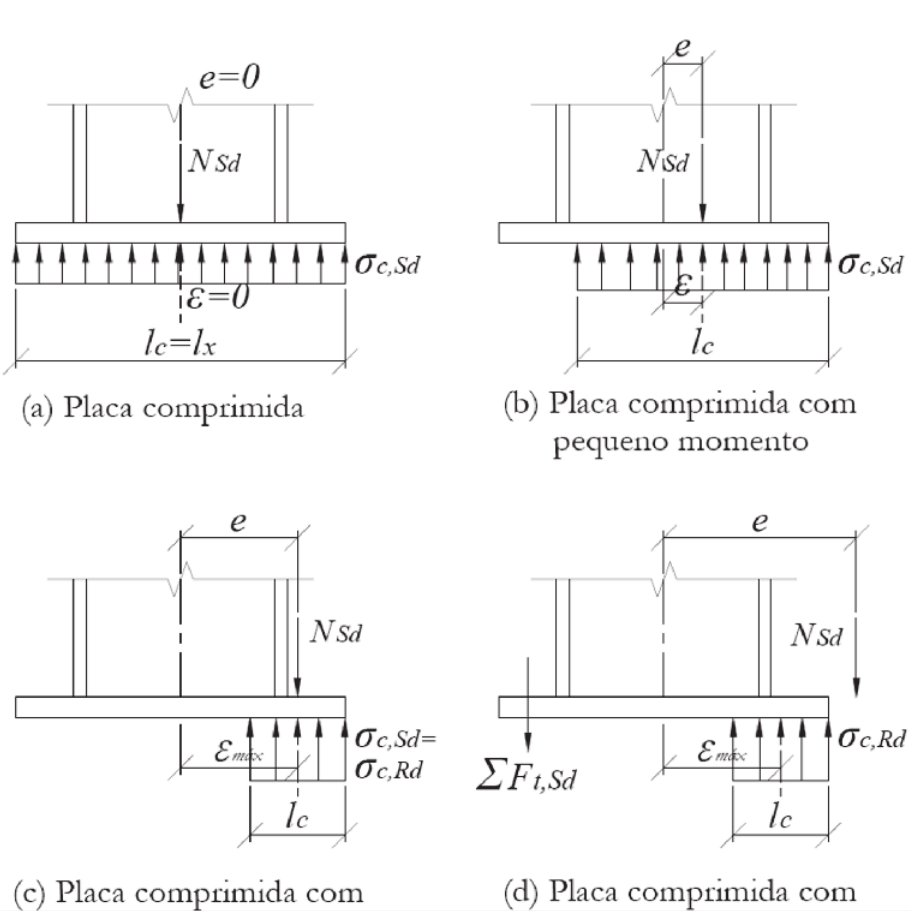
de distribuição uniforme de tensões de